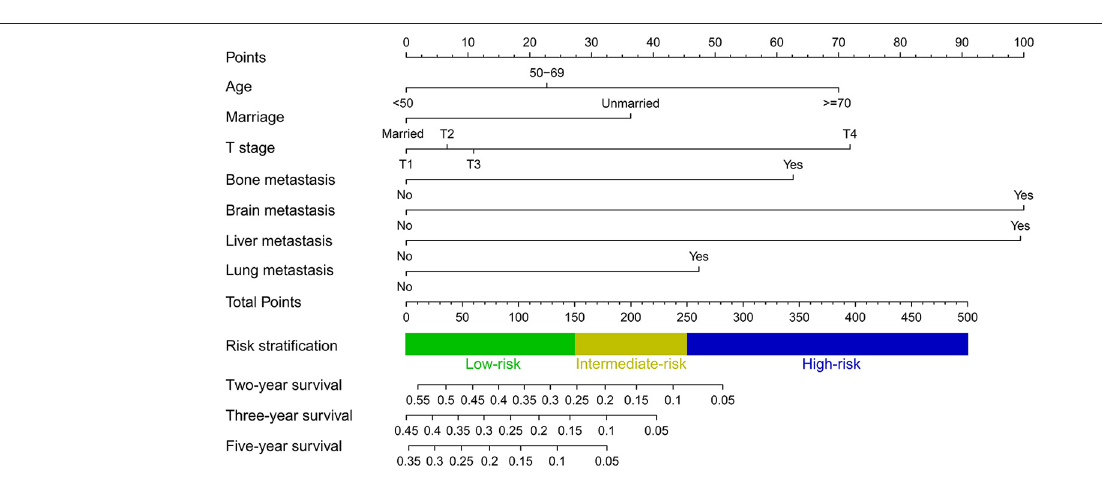
FIGURE 3 | Nomogram for predicting 2-, 3- and 5-years overall survival in TNBC patients with de novo distant metastasis.